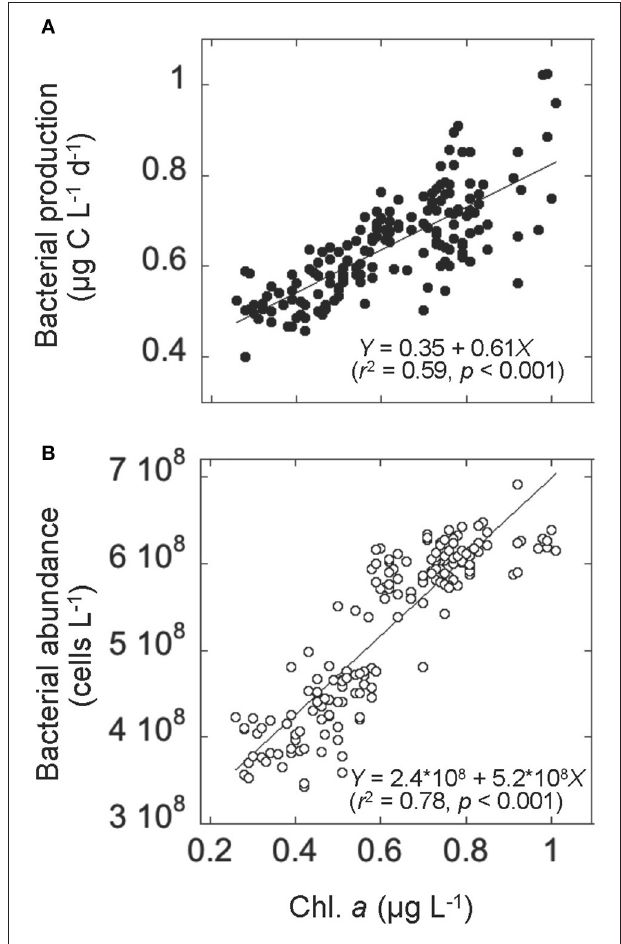
FIGURE 4 | Relationships in the upper layer between (A) chlorophyll a (Chl. a ) concentration and bacterial production and (B) Chl. a concentration and bacterial abundance. Solid lines represent the Model II regression line ( Sokal and Rohlf, 1995). The corresponding regression equations with r 2 (coefficient of determination), and p (significance) are also